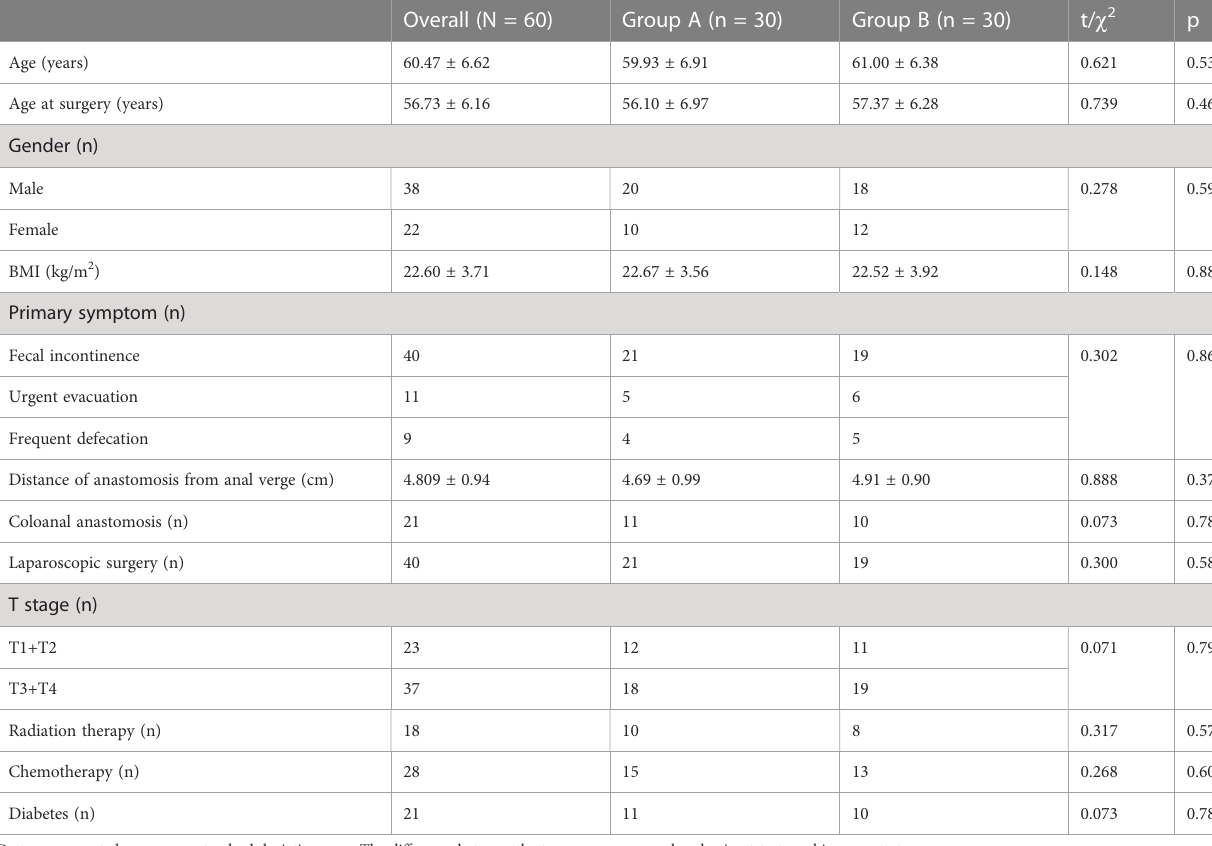
TABLE 1 Clinical characteristics of the two study groups (all patients with LARS).